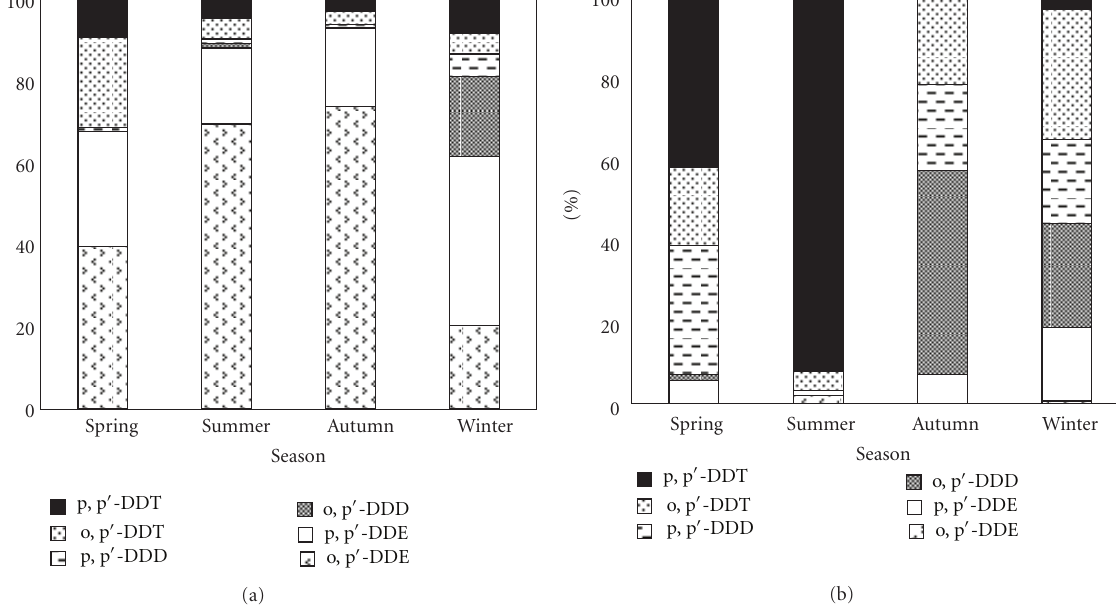
atmospheric temperature and total OCPs concentration in the particle phase at MS sampling site is − 0.703 ( P = 0 .